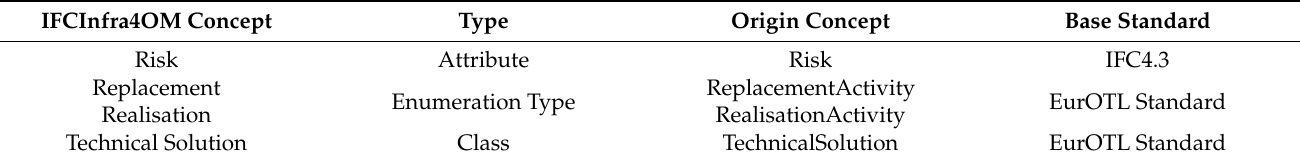
Table 6. Information Extracted from Standards and Reused in the IFCInfra4OM Data